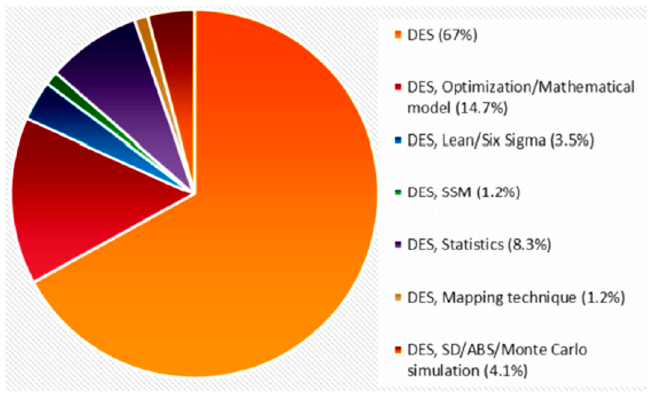
Figure 1. Frequencies of DES approaches used in applied research papers. Source: adapted from [10].